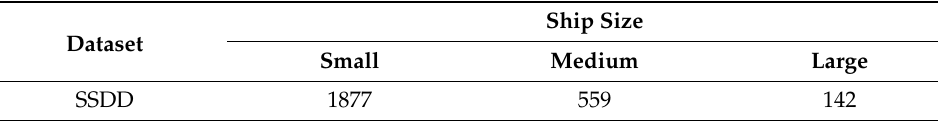
Table 2. Statistical results of multiscale ships in SSDD.